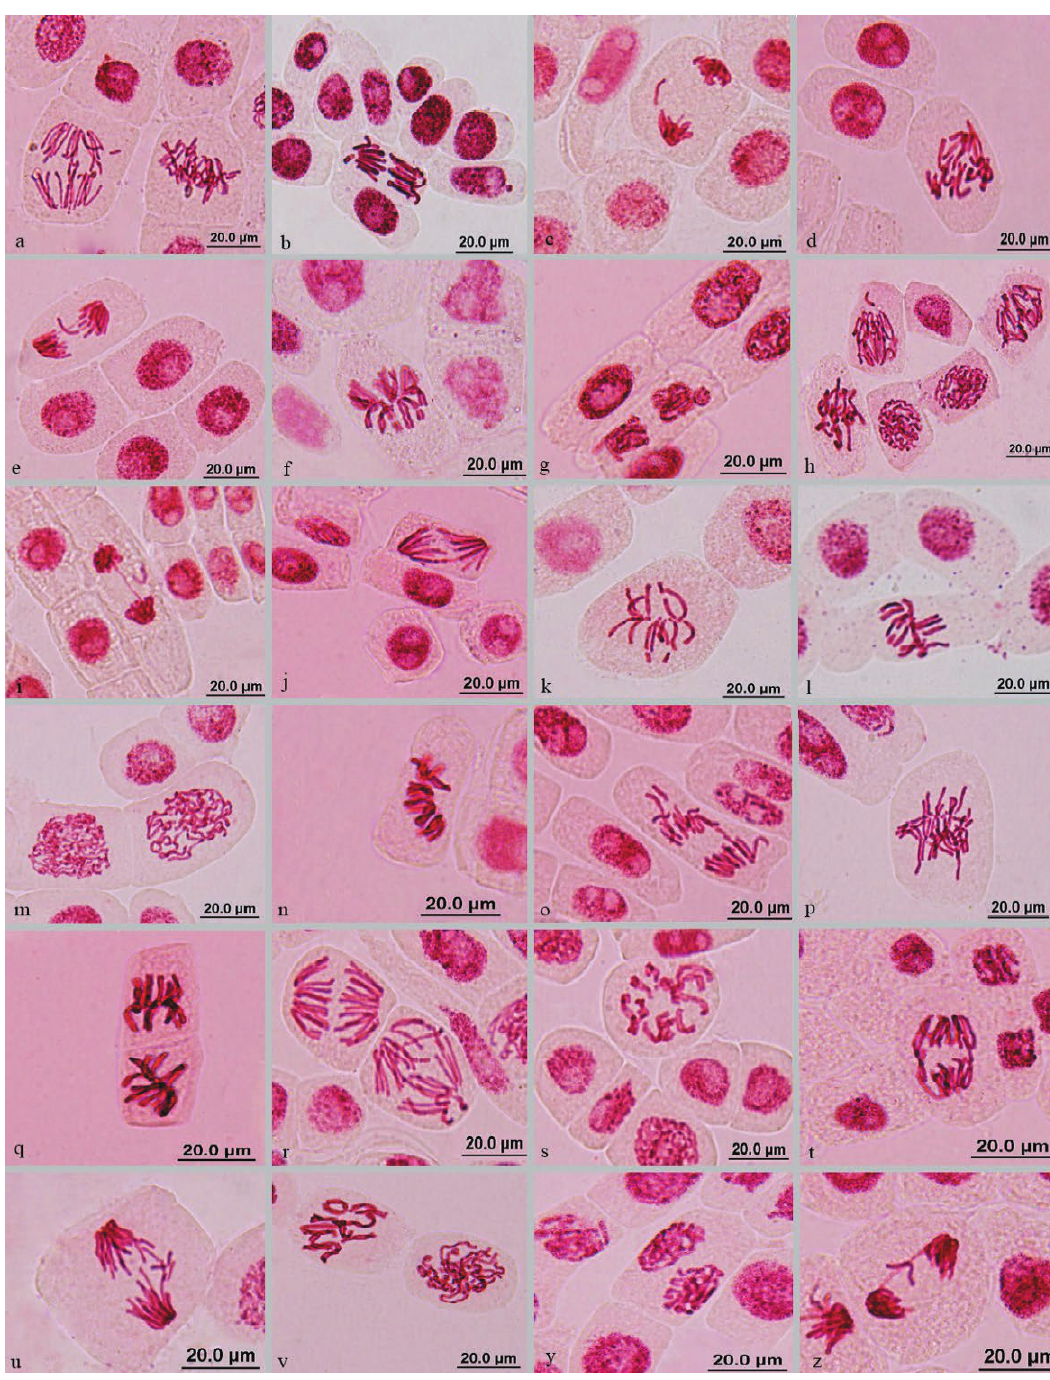
Figure 2. The chromosomal abnormalities caused by detergents in V. faba meristematic cells a. Laggard chromosome in anaphase and chro- mosome adhesion in metaphase, b. Laggard chromosome in anaphase, c. Laggard chromosome in telophase, d. Irregular anaphase, e. Chro- mosomal bridge and laggard chromosome in anaphase, f. Chromosome swelling in metaphase, g. Micronucleus formation in cytokinesis, h. Laggard chromosome and chromosome adhesion in anaphase, i. Chromosomal bridge and laggard chromosome in telophase, j. Chro- mosomal bridge and pole shift in anaphase, k. C-mitosis, l. Laggard chromosome in metaphase, m. Irregular prophase, n. Pole shift and chromosome swelling in metaphase, o. Laggard chromosome in anaphase, p. Irregular metaphase, q. Pole shift in metaphase, r. Irregular anaphase, s. C-mitosis and chromosome stickness, t. Chromosomal bridge in anaphase, u. Laggard chromosome in anaphase, v. C-mitosis and irregular prophase, y. Pole shift in telophase, z. Chromosomal bridge and laggard chromosome in